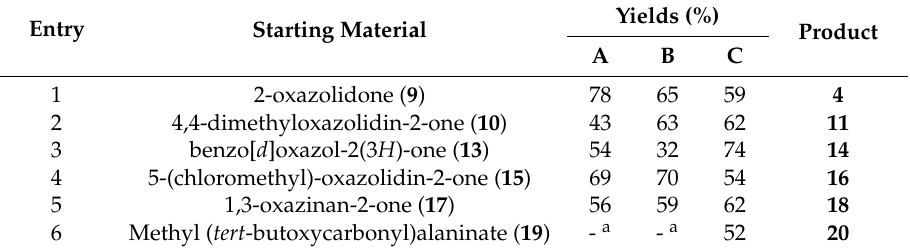
Table 1. Reaction yield for the different nitration methods on the carbamates compared. Yields (%) Entry Starting Material Product A B C 1 2-oxazolidone ( 9 ) 78 65 59 4 2 4,4-dimethyloxazolidin-2-one ( 10 ) 43 63 62 11 3 benzo[ d ]oxazol-2(3 H )-one ( 13 ) 54 32 74 14 4 5-(chloromethyl)-oxazolidin-2-one ( 15 ) 69 70 54 16 5 1,3-oxazinan-2-one ( 17 ) 56 59 62 18 6 Methyl ( tert -butoxycarbonyl)alaninate ( 19 ) - a - a 52